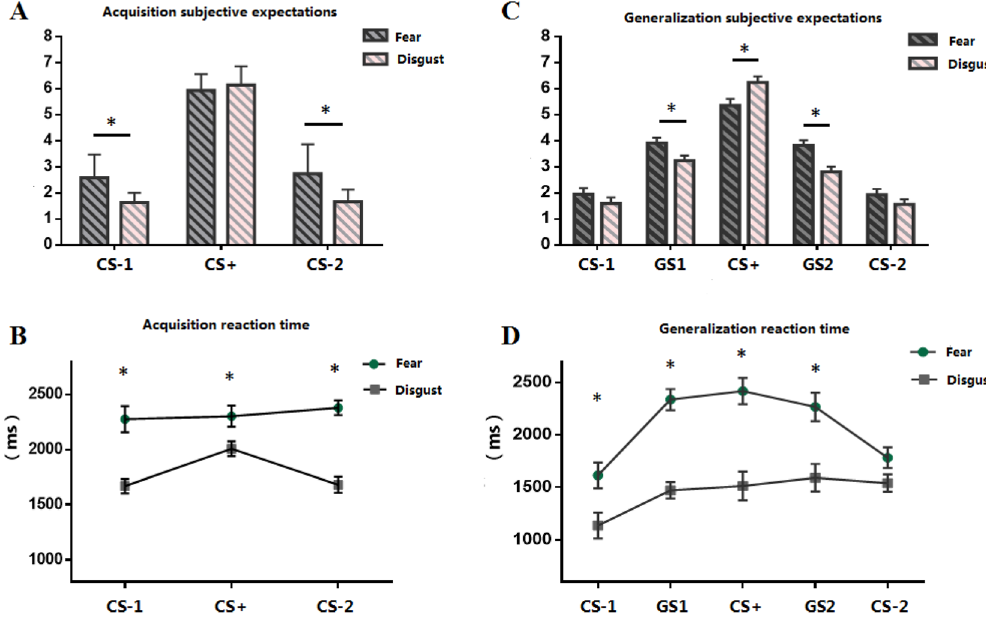
Figure 3. US expectancy ratings and mean response times were collected for each trial in the acquisition and generalization tasks. ( A ) greater subjective ratings for fear-CS- vs. disgust-CS-; ( B ) greater reaction times for fearbased CS compared to disgust-based CS; ( C ) US expectancy ratings of fear-related GS1 and GS2 were significantly greater than those of disgust GS1 and GS2; ( D ) shorter reaction times for disgusting GSs than to fearful GSs. * p < 0.05. Error bars represent standard mean errors. CS = conditioned stimulus; GS = generalized stimulus.